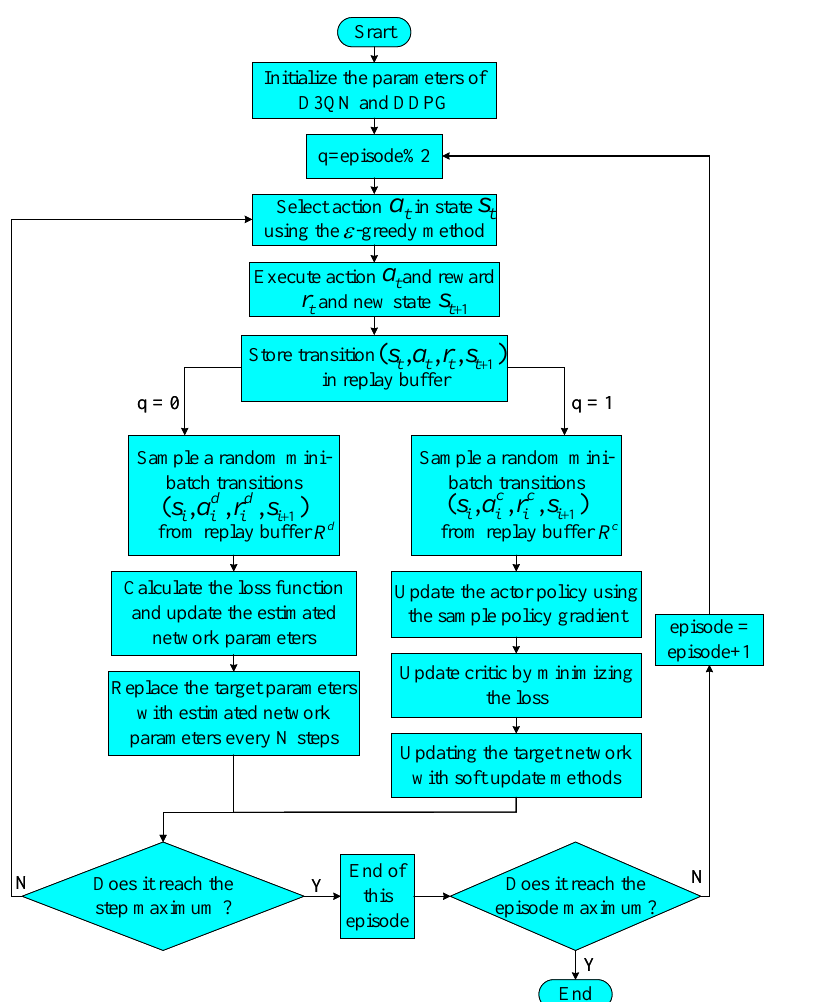
Figure 5. HDRL algorithm